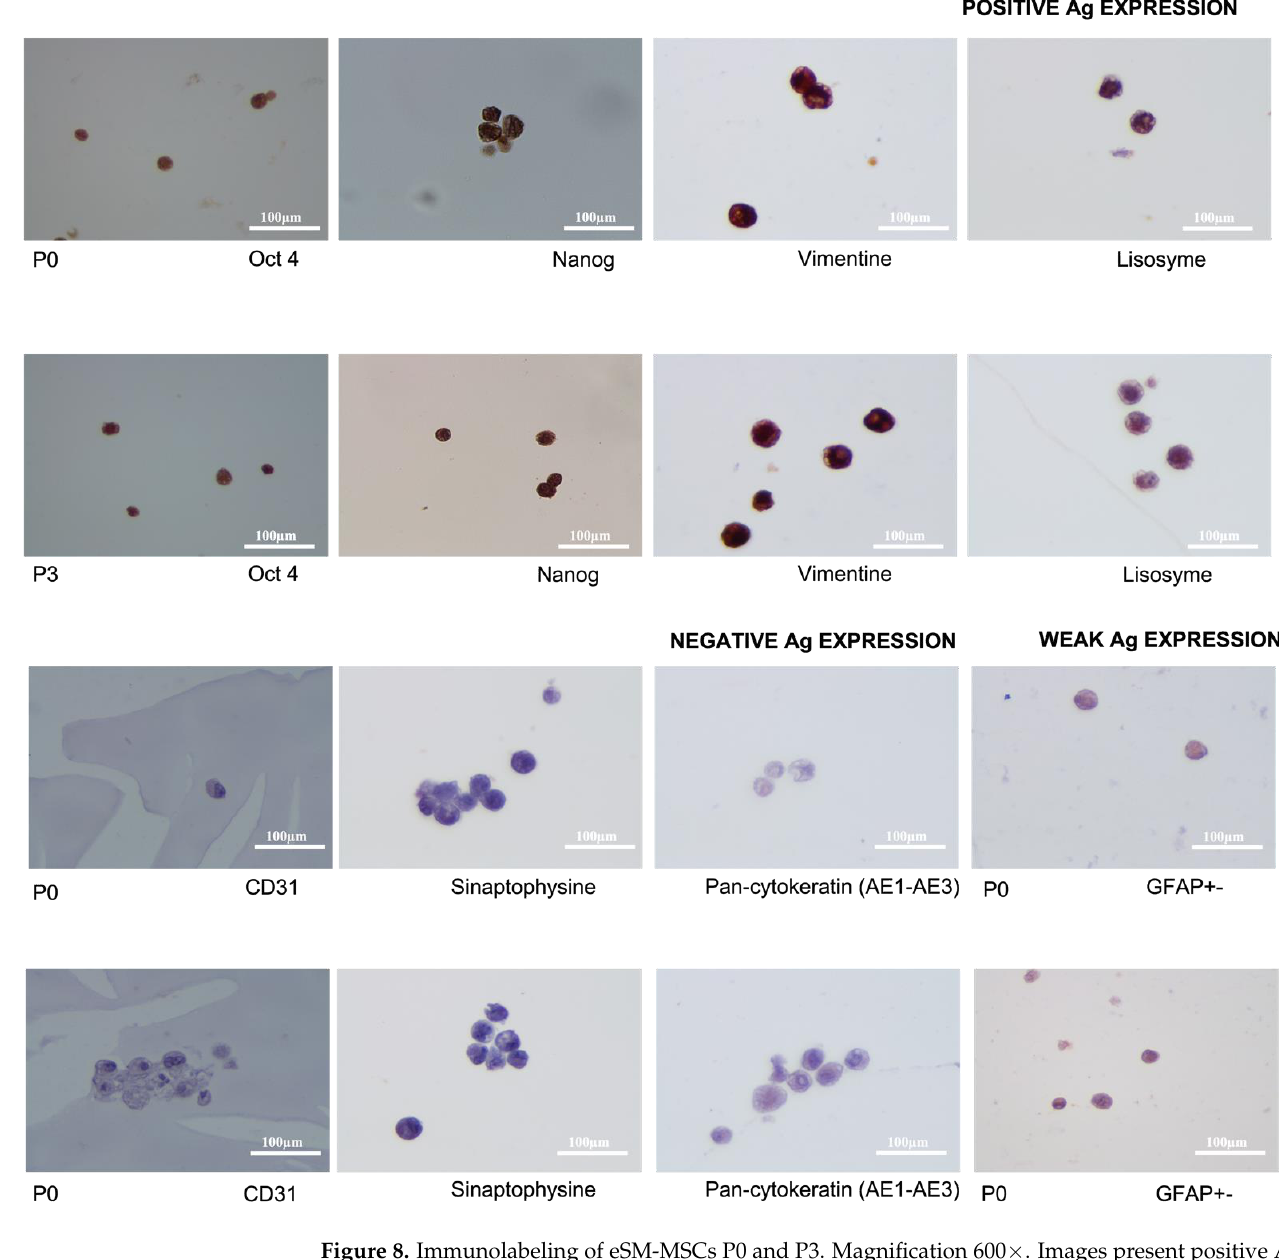
Figure 8. Immunolabeling of eSM-MSCs P0 and P3. Magnification 600x. Images present positive Ag expression of OCT4 and NANOG confirming stem cells, positive expression of vimentin confirming non-epithelial cells, and positive expression of lysozyme confirming synovial cells. Positive expression was revealed by cytoplasmatic staining of the cells. CD31, synaptophysin and pan-cytokeratin had negative expressions, did not stain, and confirmed no vascular, neuronal, or epithelial origins of cells. GFAP represents a neuronal origin of cells and had a weak expression in P0, which reduced in P3. Magnification 600×.